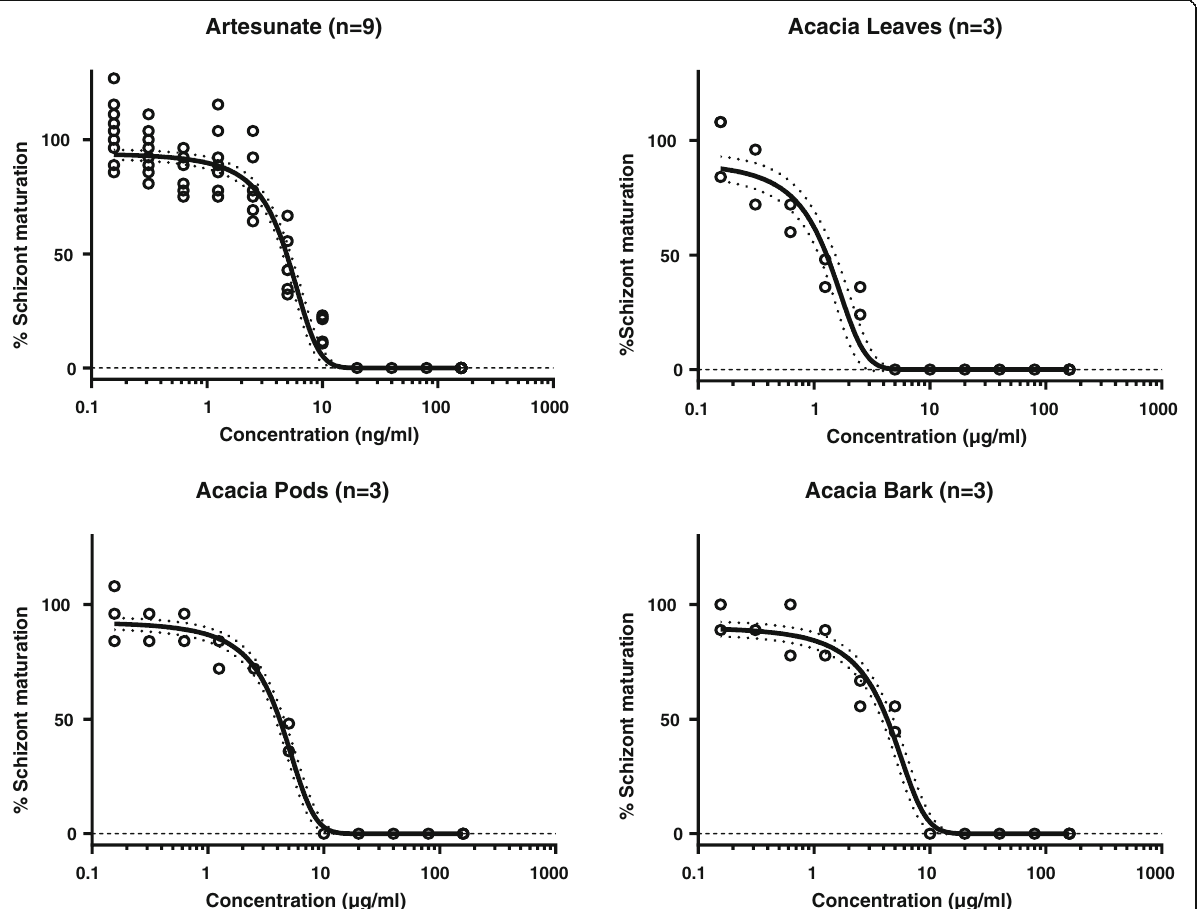
Fig. 4 Maturation of P . falciparum (3D7) after 48 h incubation with A. nilotica extracts. Open circles represent observations, the solid lines represent the estimated mean curves, and the broken lines represent the 95% confidence intervals of the mean